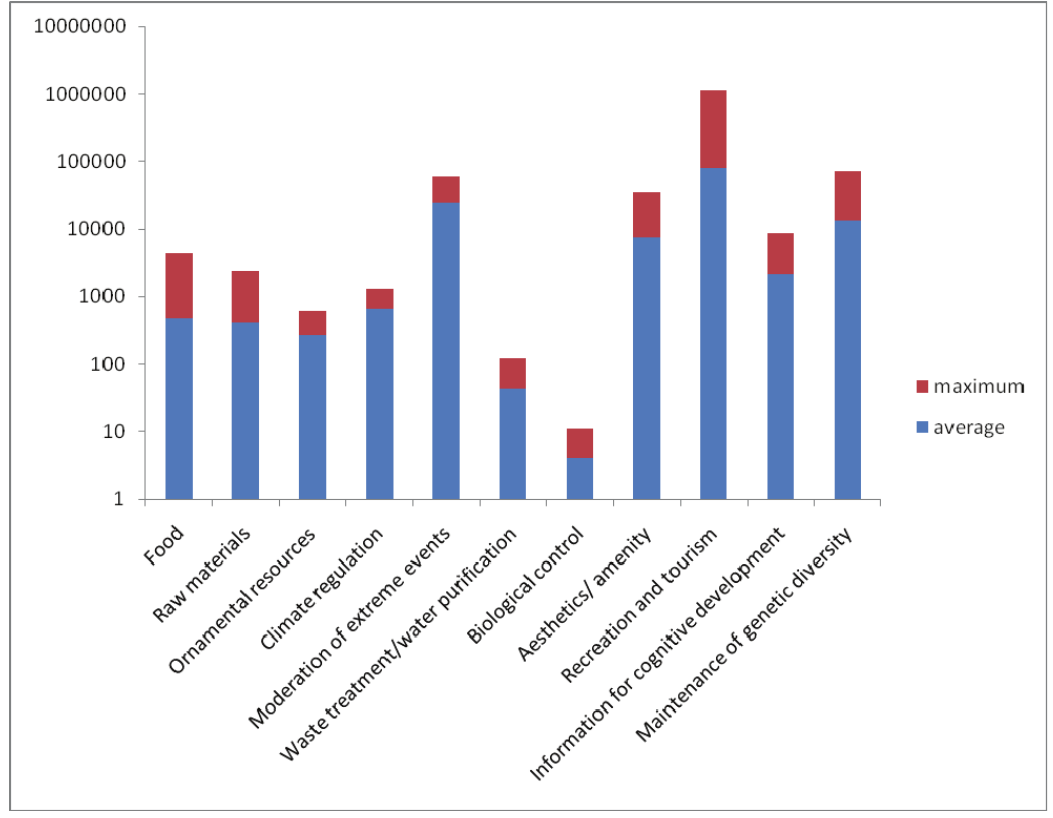
Figure 6. Economic benefits from ecosystem services for coral reef ecosystems. Values are in US$ / ha / year, on a logarithmic scale, and indicate the average value and the maximum value. Estimates taken from